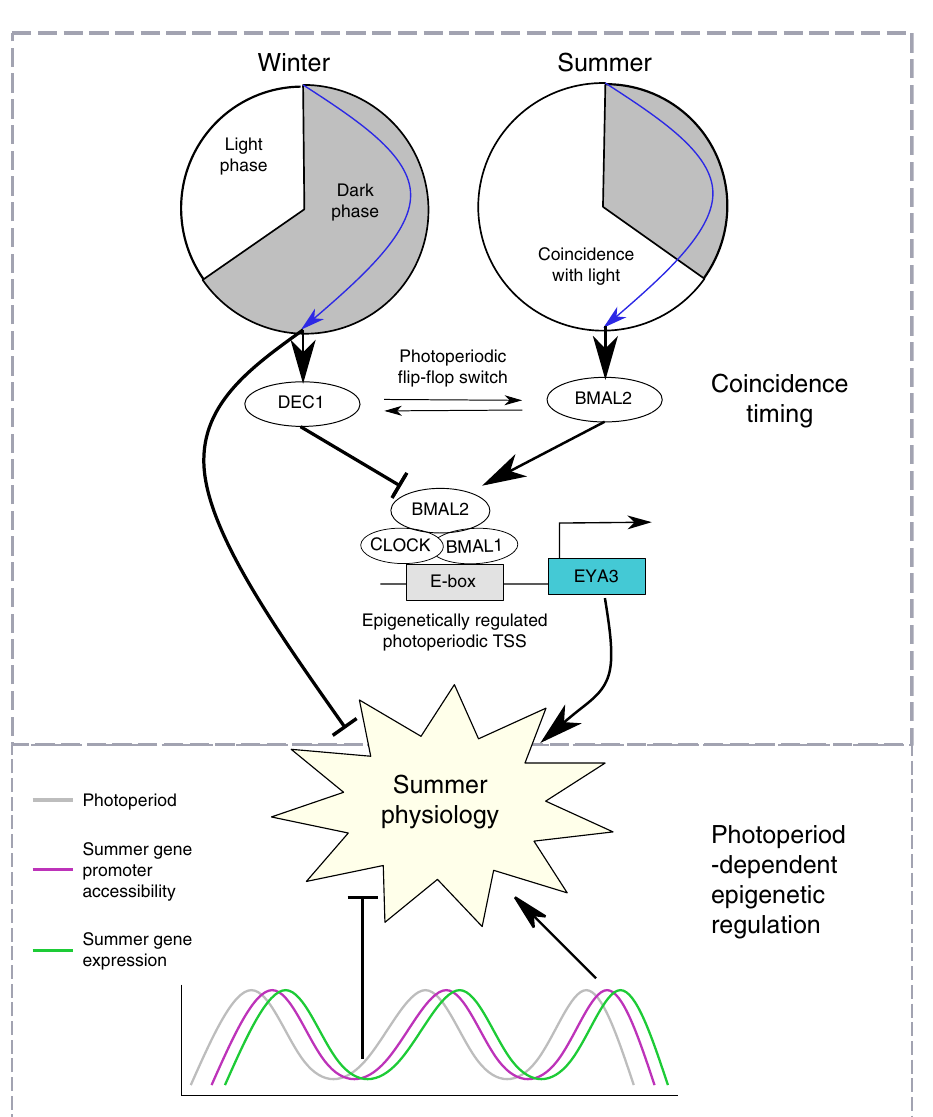
Fig. 6 Mammalian photoperiodism model: coincidence timing and epigenetic regulation. The photoperiod sculpts the duration of the melatonin signal, long duration on short photoperiods (SP, winter) and short duration on long photoperiods (LP, summer). In the pars tuberalis approximately 12 hours after the onset of darkness there is a photosensitive phase. When this phase coincides with light BMAL2 is expressed. When this phase is coincident with darkness DEC1 is expressed. This forms a photoperiodic fl ip- fl op switch between two stable states. The role of BMAL2, CLOCK and BMAL1 is to co-activate EYA3 and subsequently seasonal physiological changes. DEC1 suppresses the E-box based activation of EYA3. Also occurring in the dark phase of SP a number of repressors are expressed which target appear to target LP induced genes potentially inhibiting the expression of summer physiology. Aside from this acute photoperiodic fl ip- fl op switch there is a progressive photoperiod dependent epigenetic regulation over a number of weeks augmenting the coincidence based timer drive on summer